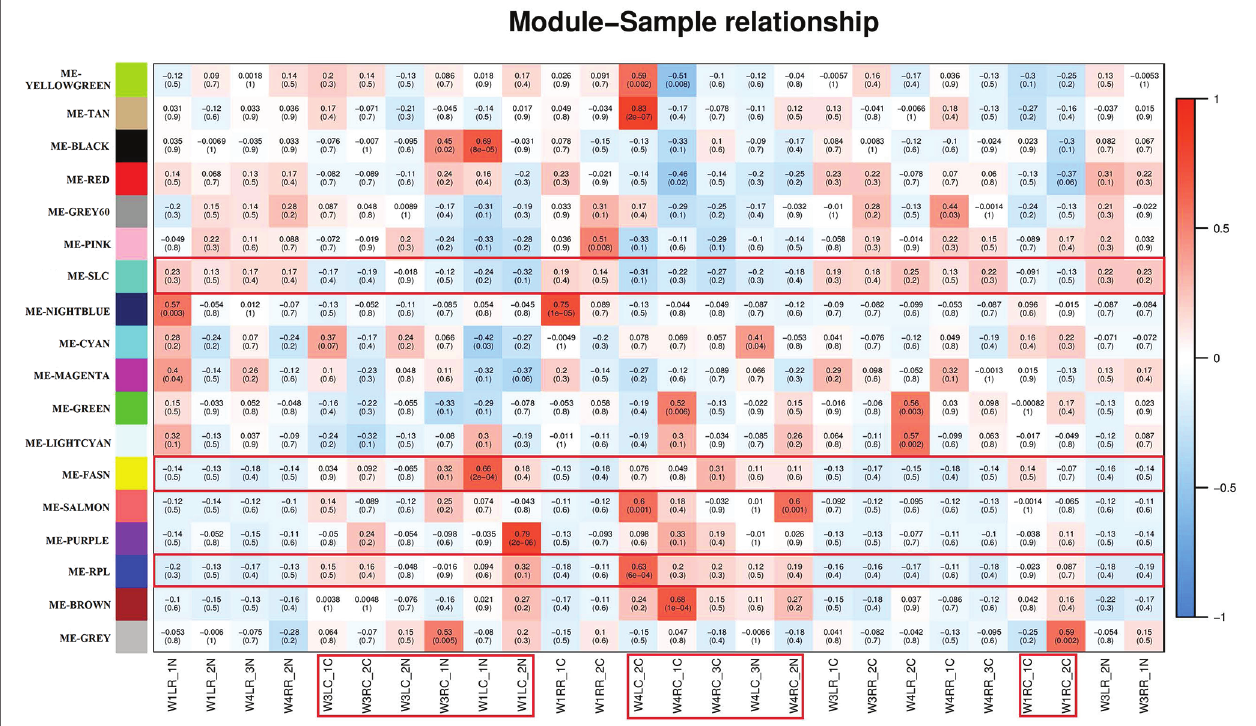
FIGURE 6 | Module – Sample relationships. The abscissa is the sample and the ordinate is the module. The numbers represent correlation between the module and the sample. Closer the value is to 1, stronger the positive correlation between the module and the sample; closer to − 1, stronger the negative correlation. The number in brackets represents value of p , smaller the value, and higher the significance. The red specimen is choroid of the tree